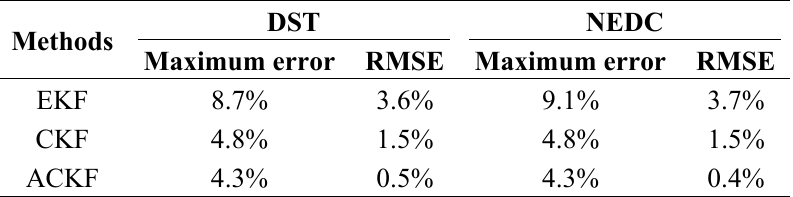
Table 3. Comparison of SOC estimation with measurement